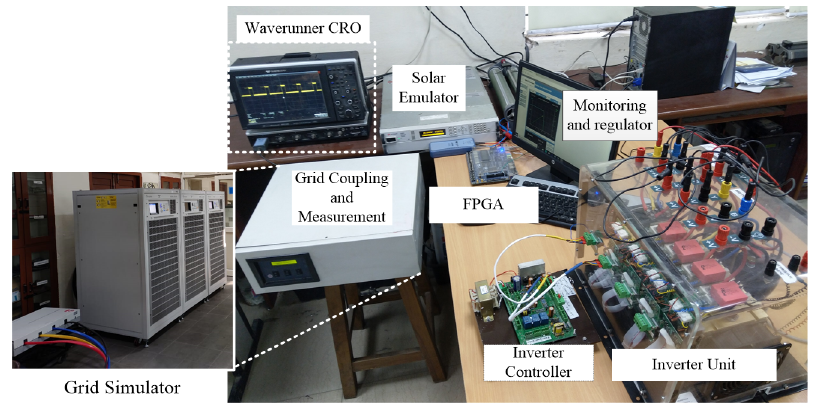
Figure 9. Test arrangement of a single-phase grid-connected photovoltaic system.